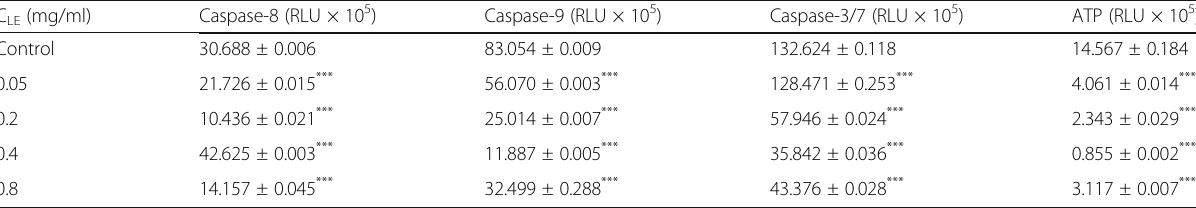
(Values expressed as mean ± SD, *** p < 0.0001 compared to the